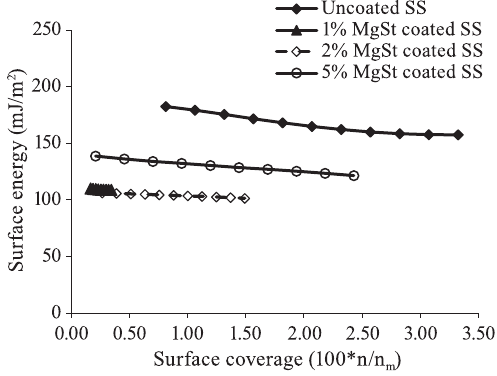
Fig. 5 The relationship between estimated modelling parame- ters ( a = maximum relative de-agglomeration, b = dif- ference in flow rate between 75 % and 25 % of the rela - tive de-agglomeration and x 0 = air flow to achieve 50 % of the maximum relative de-agglomeration) with the uncoated (0 % Magnesium stearate, MgSt) and coated (1, 2 and 5 % MgSt) salbutamol sulphate (SS) powders ( n = 2)